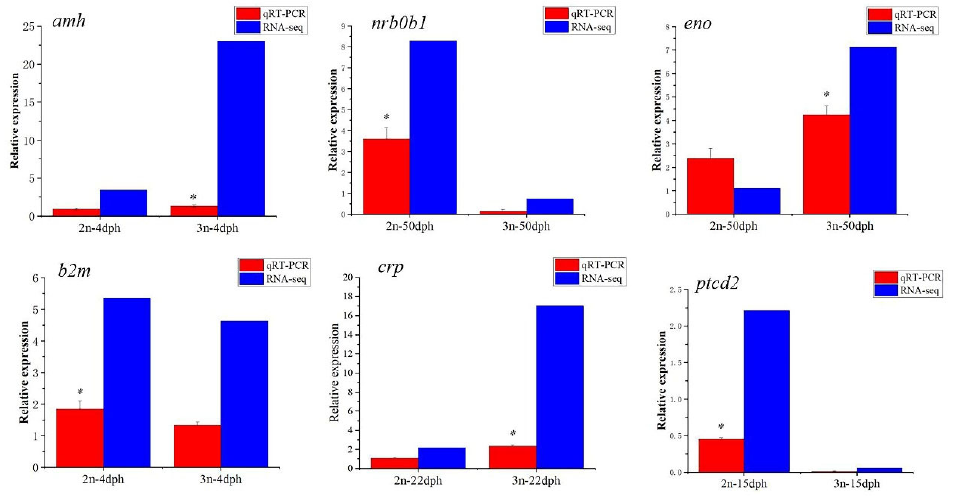
Figure 10. Real-time fluorescence quantitative PCR results of six DEGs. * signifies p < 0.05, which denotes a significant difference between hybrid triploid and diploid loaches.